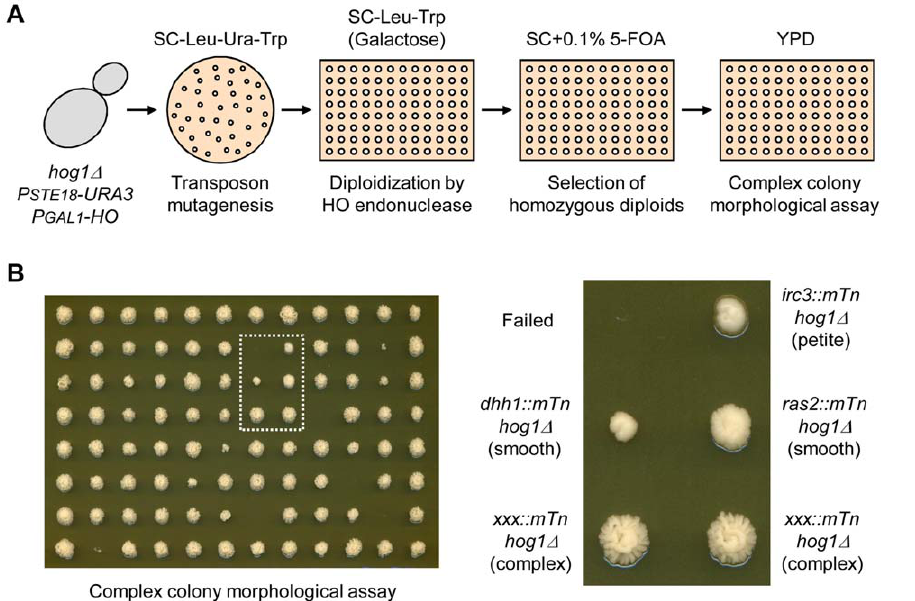
Figure 3. Screening suppressor mutations of the complex colony morphology or hyper-filamentous growth phenotype in the hog1 D /hog1 D backgrounds. (A) Strategy for screening the suppressor mutations. Using the haploid hog1 D PSTE18-URA3 strain carrying pJH283 ( PGAL1-HO::TRP1 ) as a host strain, transposon insertion mutagenesis was performed and mutant strains defective in complex colony morphology were screened by visual inspection. The details are described in Materials and Methods. (B) One example of the screening results is shown. The candidates, smooth colony or less complex colony, were further analyzed: identification of the transposon insertion position, mating-type PCR, and morphological assay for invasive growth and filamentous growth.